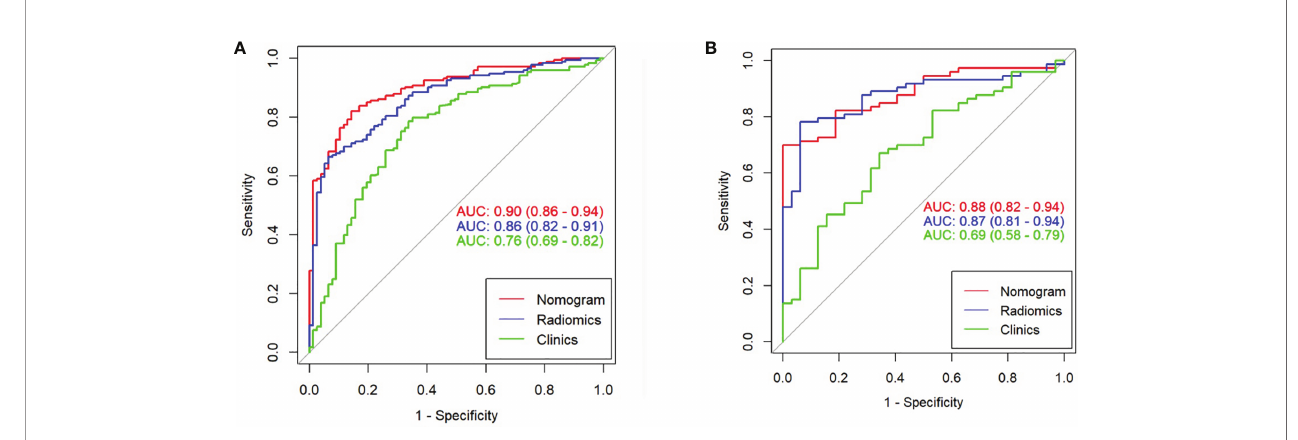
FIGURE 6 | Comparison of ROC among the nomogram, radiomics model, and clinical model for the prediction of GC-PM in the (A) training and (B) validation cohorts.